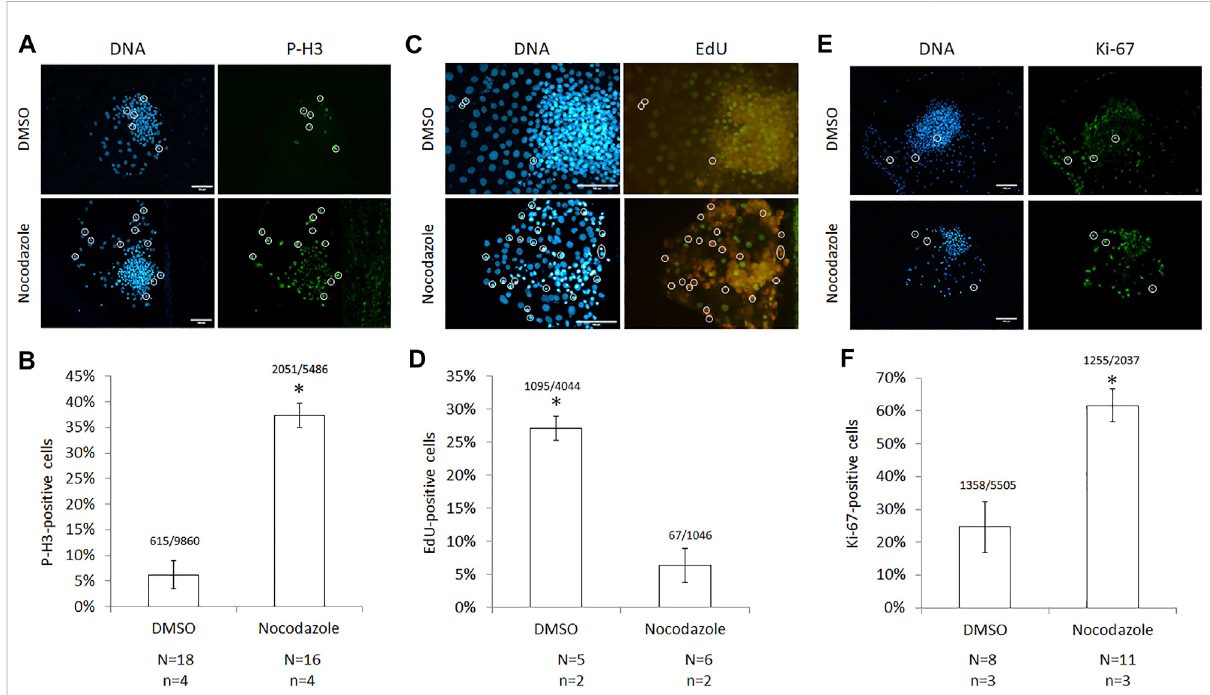
FIGURE 2 Cell-cycle characterization of nocodazole-arrested ICM cells. (A) Images and (B) quanti fi cation of cells with phosphorylated histone 3 (P-H3) following nocodazole synchronization for 18 – 22 h. A total of 15,346 Hoechst-stained nuclei (DNA) were counted. (C) Images and (D) quanti fi cation of cells with 5-ethynyl-2 ′ -deoxyuridine (EdU) incorporation after a 30 min label following synchronization; 5,090 Hoechst-stained nuclei were counted. (E) Images and (F) quanti fi cation ofcells expressingKi-67followingsynchronization;7,542 Hoechst-stained nuclei werecounted.For all panels, circles identify mitotic nuclei, scale bar = 100 μ m, error bars = SEM, N = colonies counted per treatment , n = technical replicates, and * = p < 0.00001 from two-tailed t -test compared with